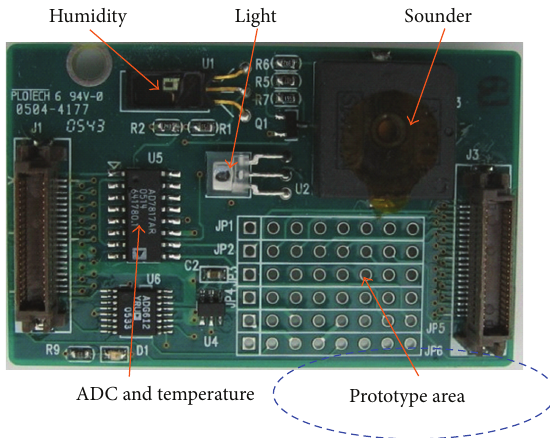
Figure 3: Sensing module for ITRI SCAN-ZB32. A prototype area is provided for other extended sensing functions.